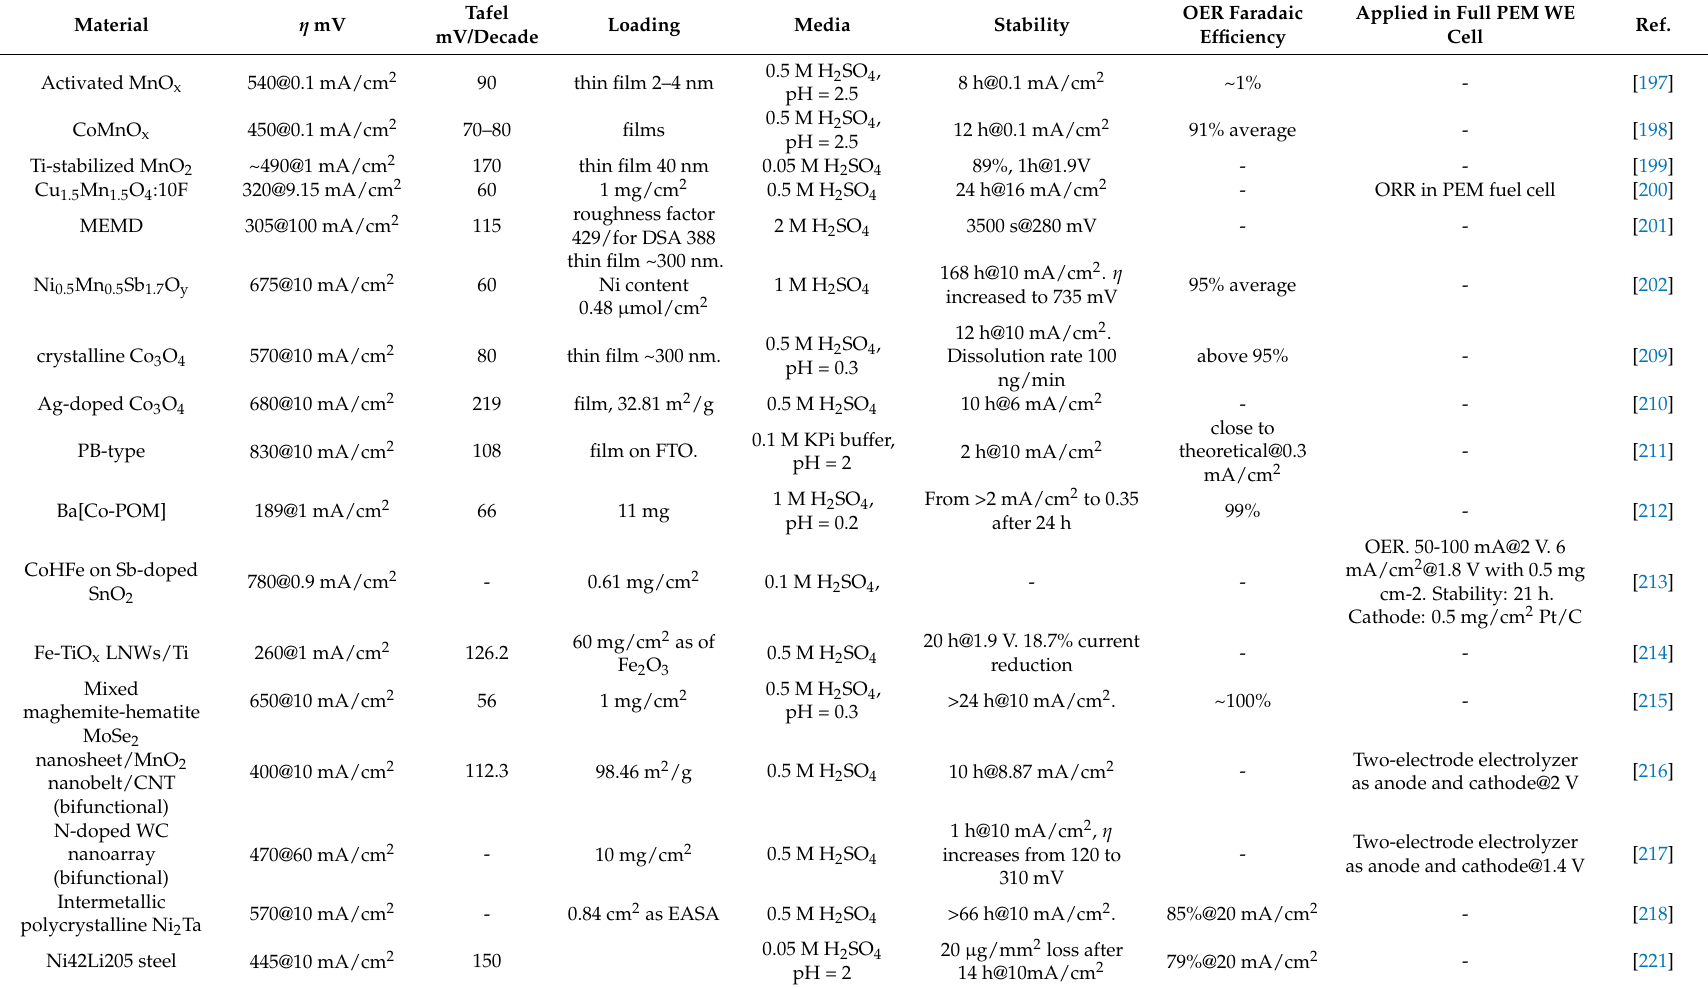
Table 4. Summary of the EACs developed for OER in acidic